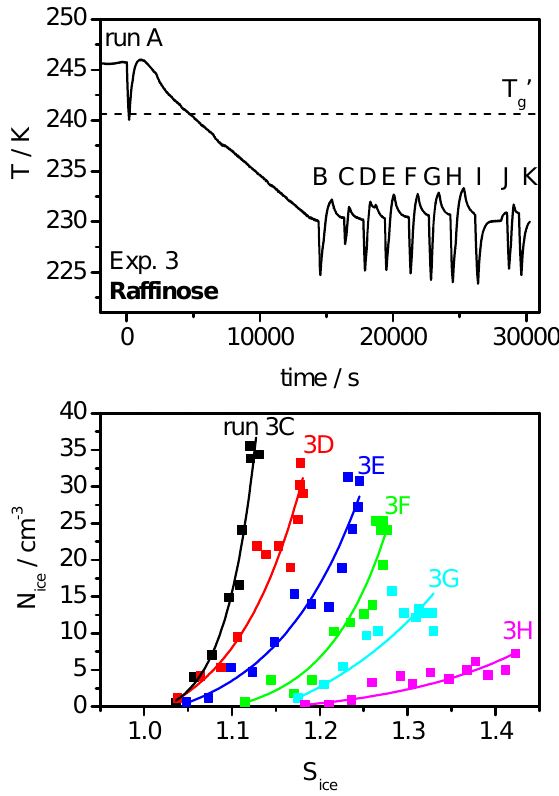
Fig. 9. Top panel: Temporal evolution of the AIDA gas tempera- ture during Exp. 3 with aqueous raffinose aerosol particles. Bottom panel: Number concentration of nucleated ice crystals, N ice , as a function of the supersaturation with respect to ice, S ice , during the expansion runs 3C – 3H (squares). For run 3H, only the data of the pre-activation but not the subsequent homogeneous freezing mode are included. The data were fitted by an exponential approximation as described in M¨ohler et al. (2006). Each individual trace covers the time period from the nucleation onset until reaching the maxi- mum ice particle number concentration during the expansion